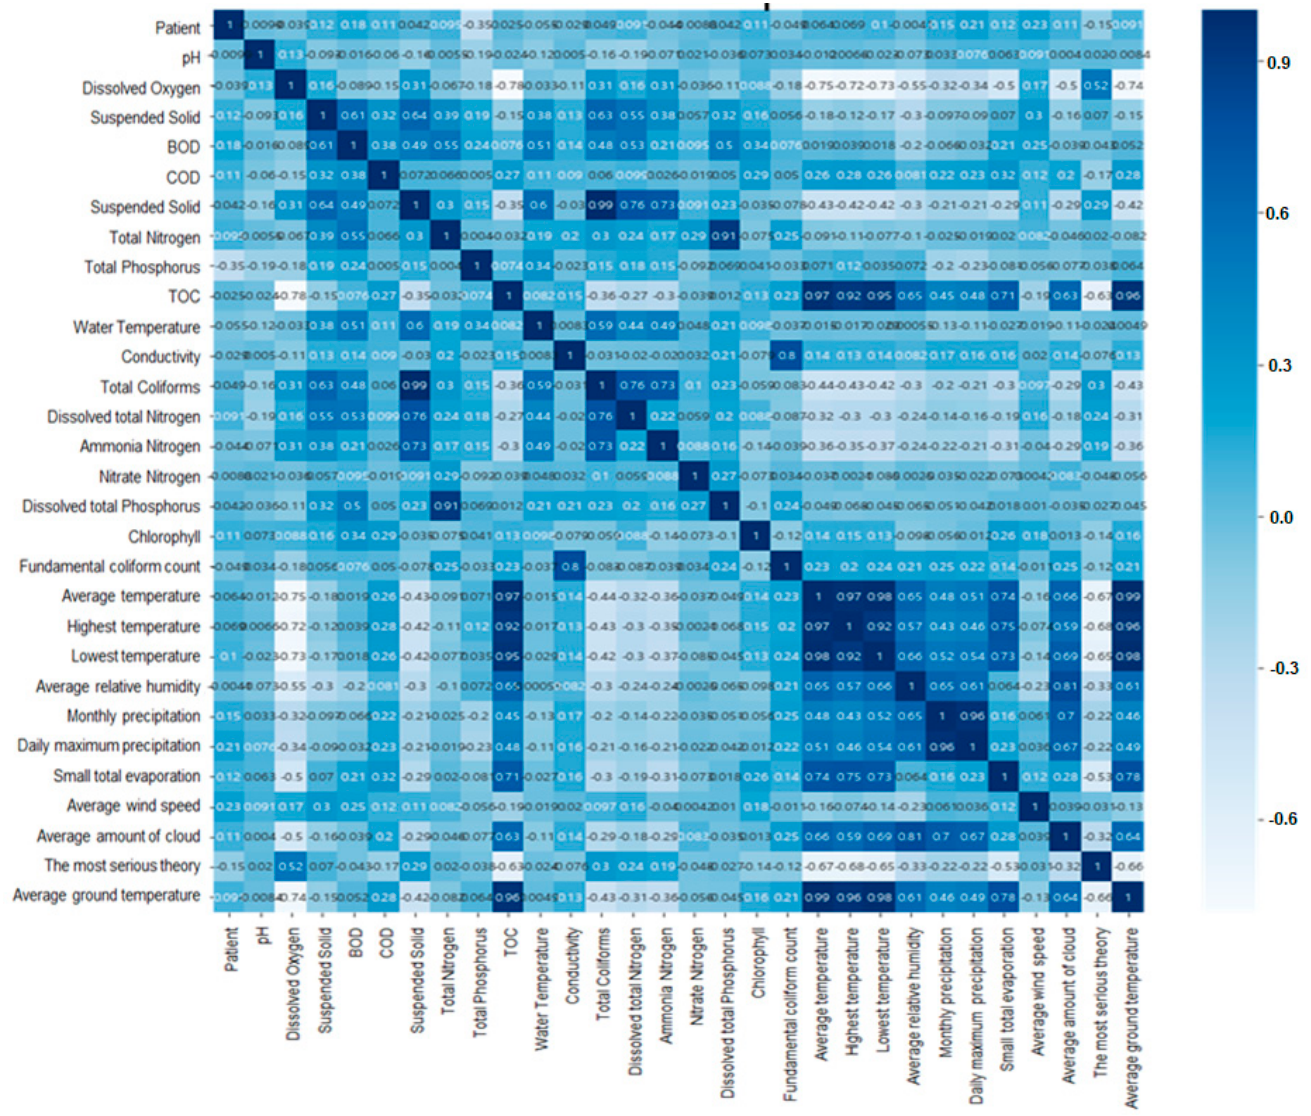
Figure 5. Linear model based statistical test on the relationships between hepatitis A and environ- mental factors ( a ): theoretical quantiles vs standardized residuals; ( b ): leverage vs standardized re- siduals.